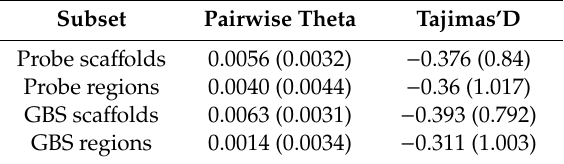
Table 3. Median and standard deviation (in parenthesis) for nucleotide diversity and Tajima’s D for the different data sets.